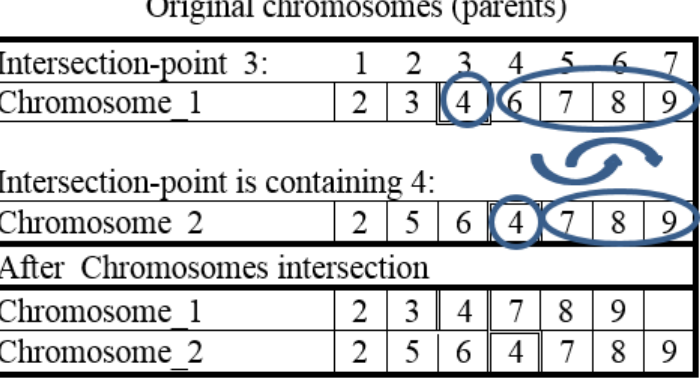
Figure 4. Standard crossover samples.